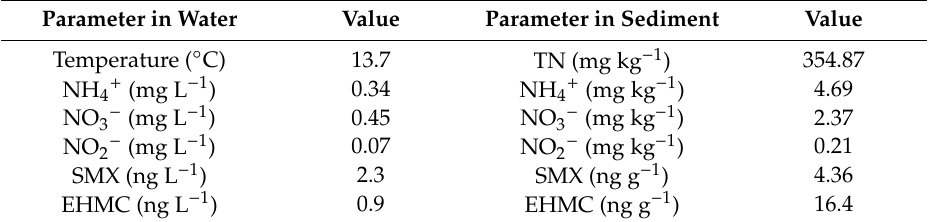
Table 1. The water quality parameters and sediment physicochemical